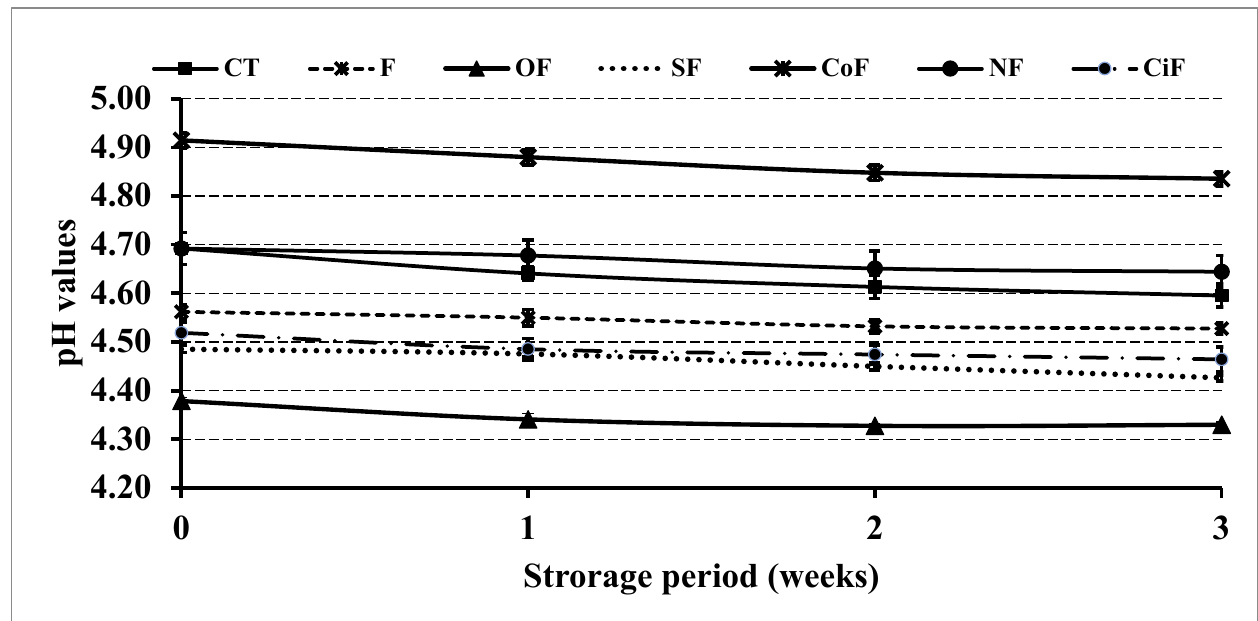
Figure 1. pH development of frozen yoghurt during storage as affected by using chufa milk and different flavoring materials (mean ± SE of 3 replicates). Refer to materials and methods for treatments details.